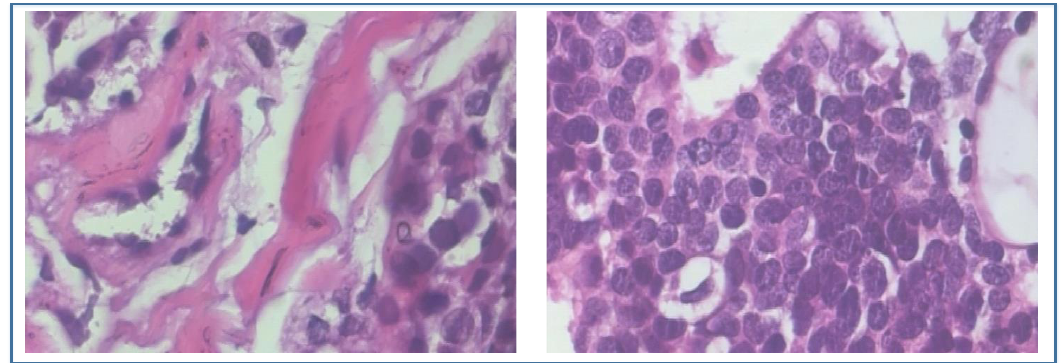
Figure 2. The left side represents the Benign and right side Malignant histopathological images (This data has been collected from the BreakHis